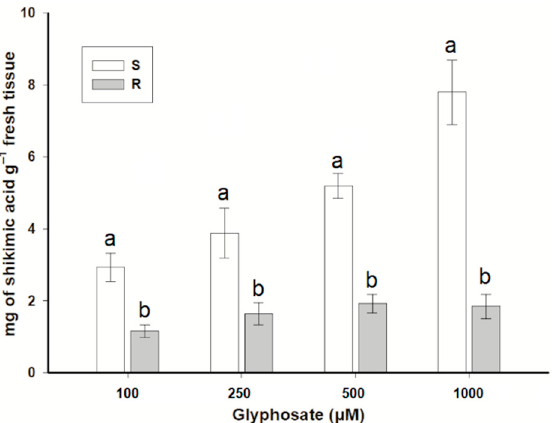
Figure 2. Shikimic acid accumulation in susceptible (S) and resistant (R) Eleusine indica plants at different glyphosate concentrations. Histograms represent the means and vertical bars of the standard error ( n = 10). Different letters within each group of bars did not differ statistically at the 95% Tukey test.